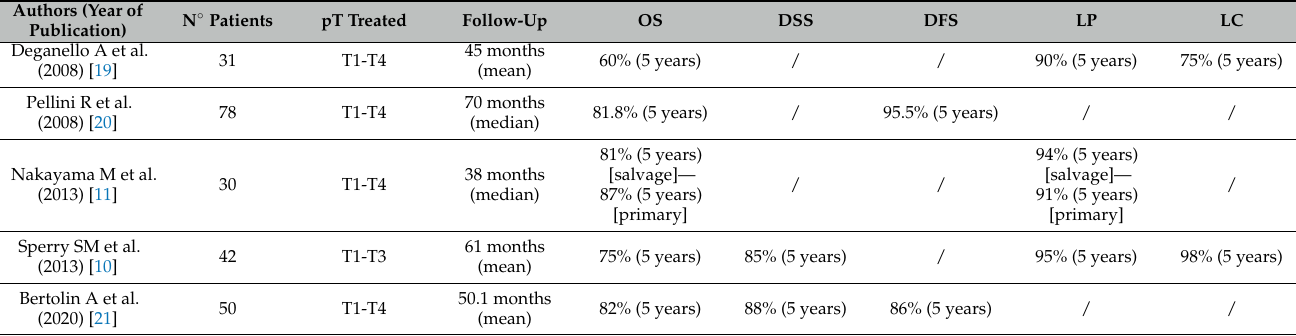
Table 2. Salvage OPHL type II: characteristics of included